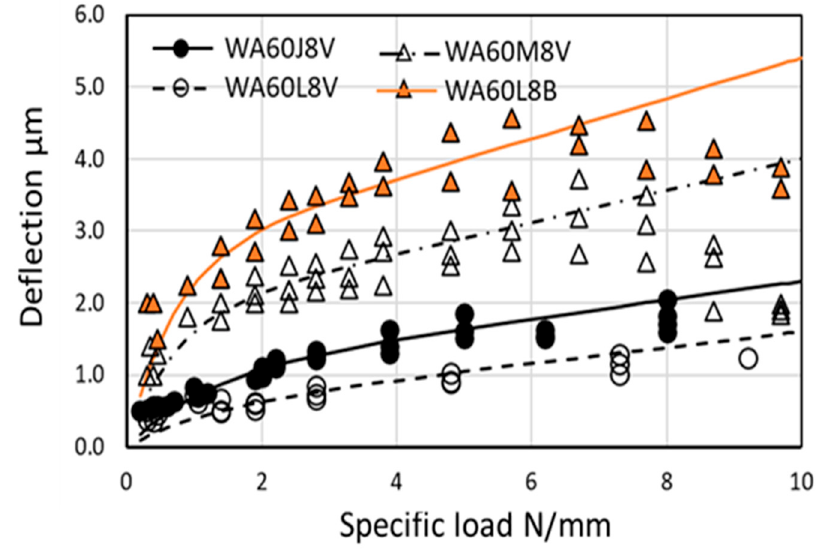
Figure 17. Contact deflection of various Al 2 O 3 #60 grinding wheels.